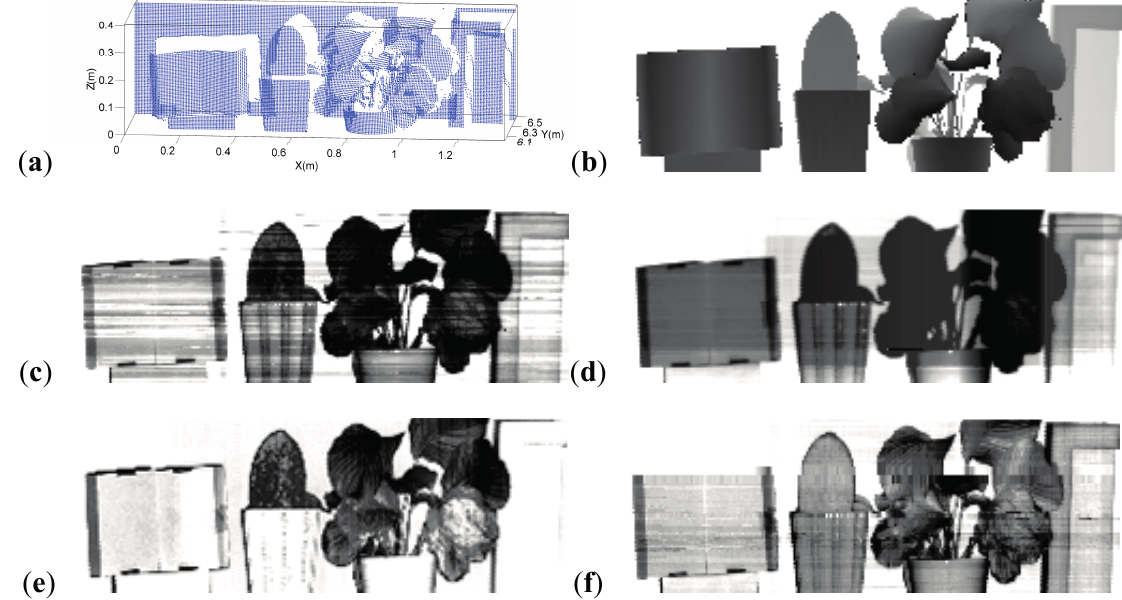
image, and MSL are shown in Figure 6.